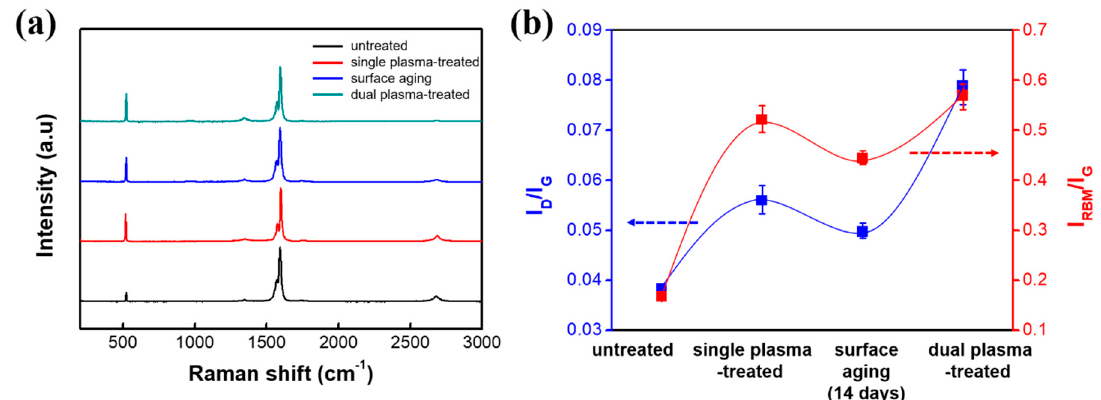
Figure 3. Changes in chemical structure and vibrational characteristics of the SPT- and the DPT-SWCNTs. ( a ) Raman spectra and ( b ) variations of I D /I G and I RBM /I G ratios.